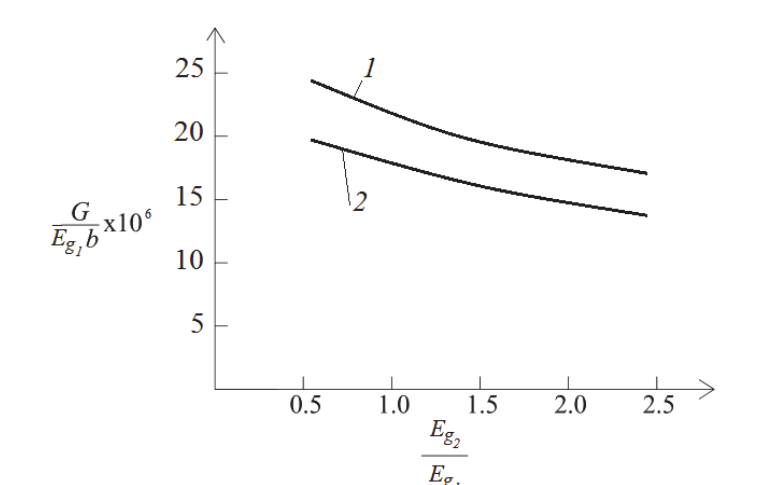
Figure 5: The strain energy release rate in non-dimensional form presented as a function of mechanical behavior of the material, curve 2 – at linear-elastic